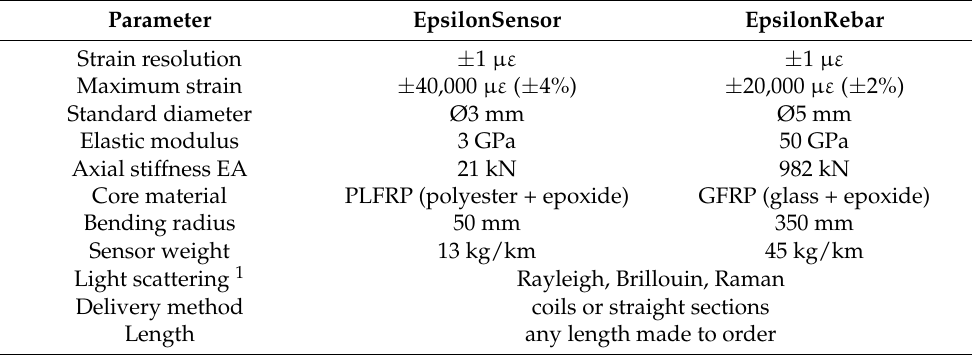
Table 1. Comparison between the parameters of two different monolithic strain sensors